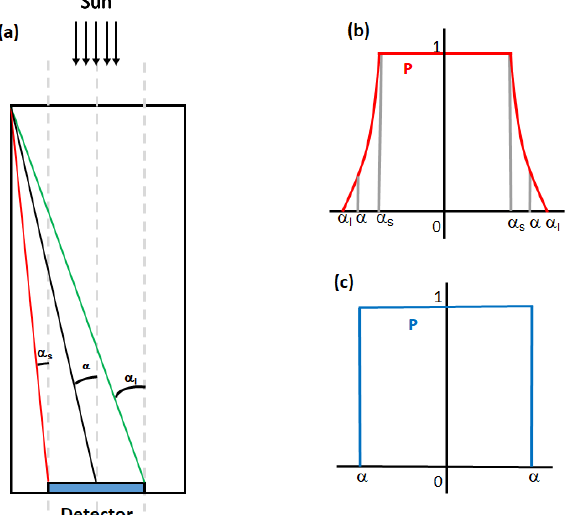
Figure 2. (a) Characteristic angles of the instrument: slope angle α s , aperture half-angle α , and limit angle α l . On the right, penumbra functions P(α) when (b) the three angles are known and (c) only if the angle of the half-angle is known. (Figure adapted from Blanc et al., 2014.)